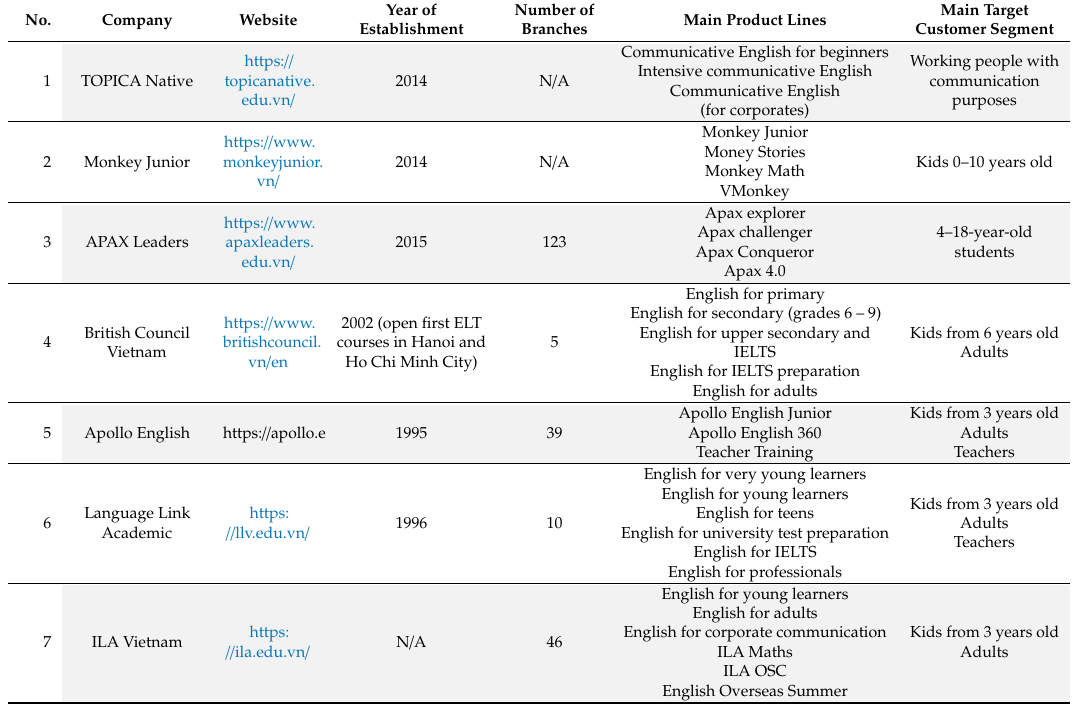
Table 1. Leading companies in ELTM in